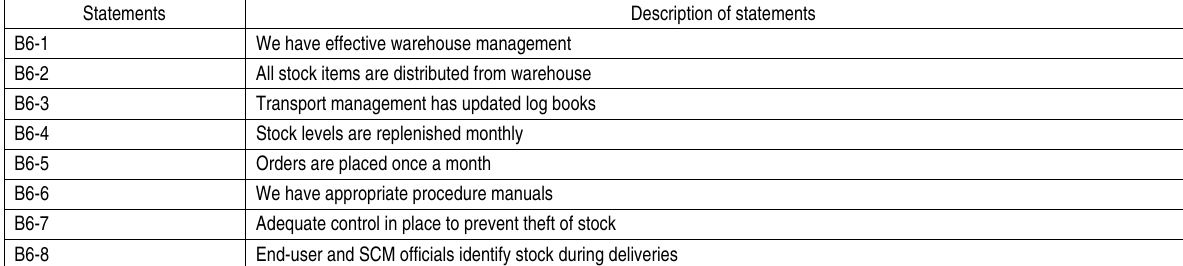
Table 7. Description of statements in Table 6 relating to logistic management